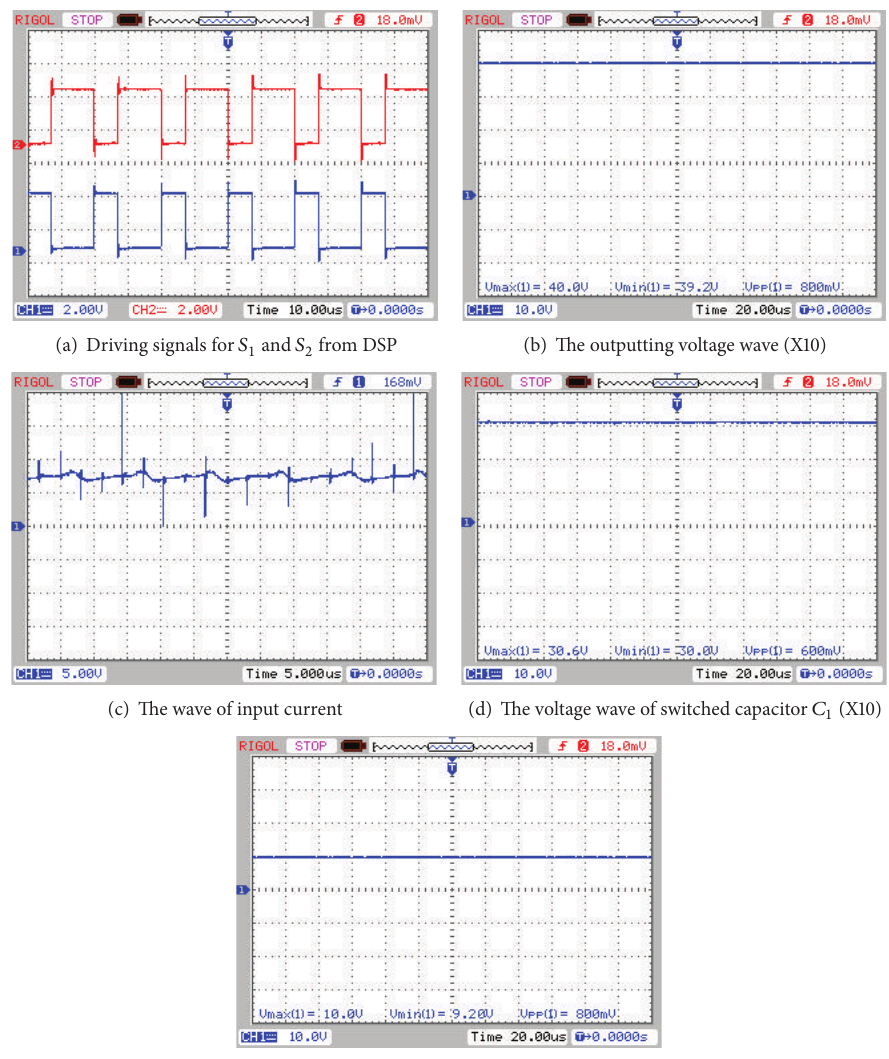
Figure 11: Experimental